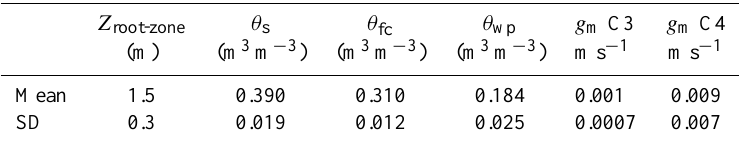
Table 8. Mean and SD of the parameters used in the Monte Carlo analysis. g m C3 and g m C4 denote the mesophyll conductance for C3 and C4 crops. The mean values are those used in the simulation FIELD cst